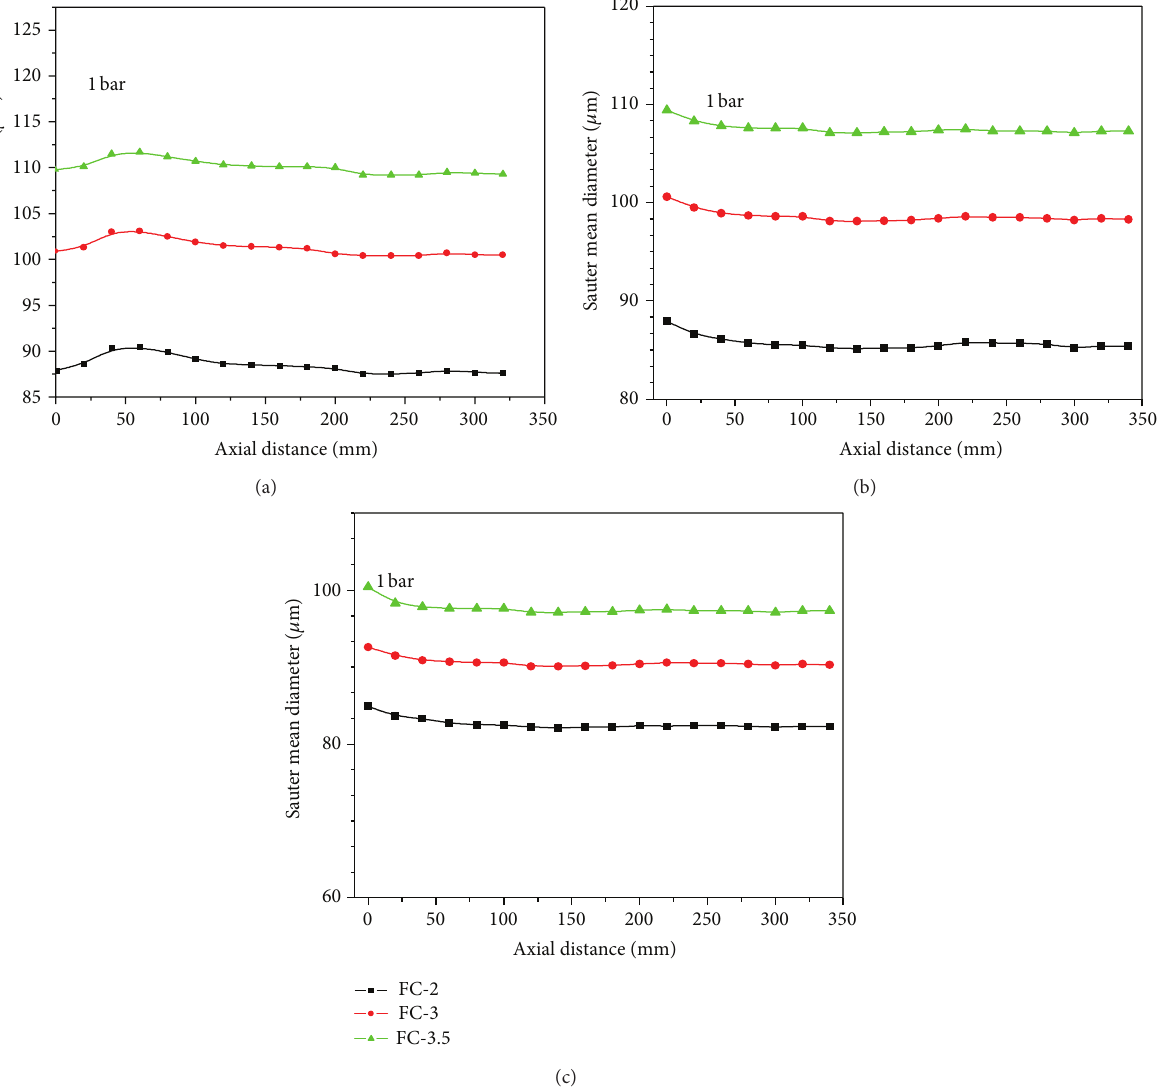
Figure 6: SMD as a function of axial distance from the nozzle tip for fixed temperature of (a) 20 ∘ C, (b) 60 ∘ C, (c) 90 ∘ C.